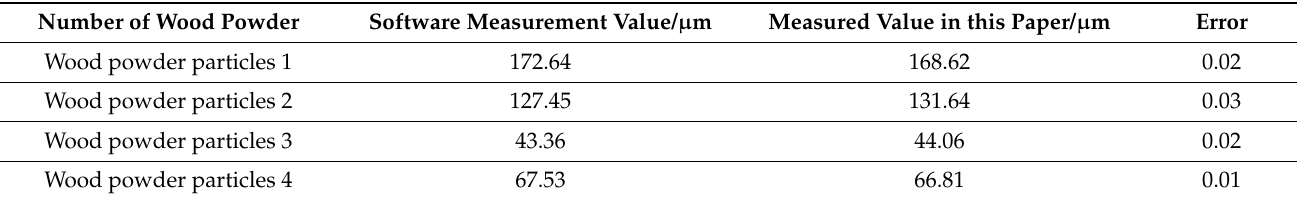
Table 3. Values and errors η of the measurement of diameter.